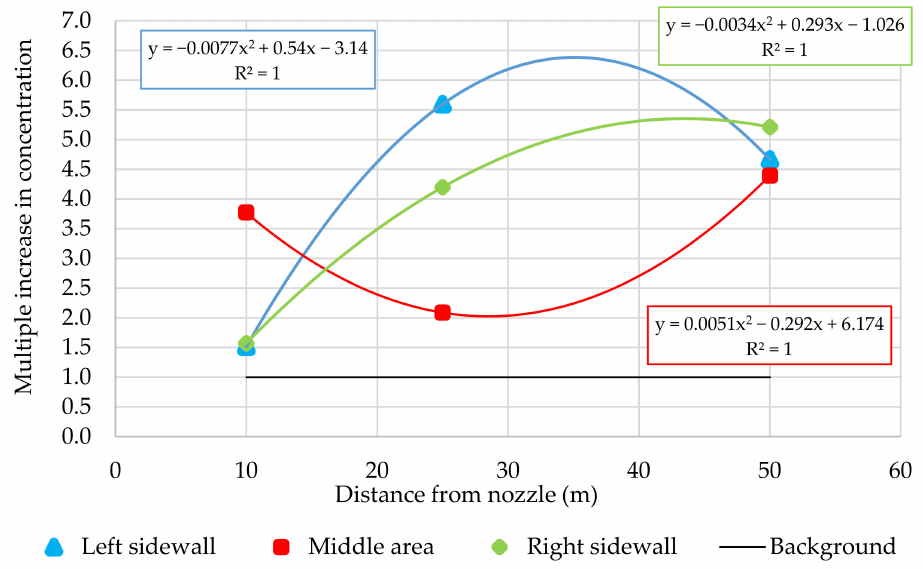
Figure 17. Distribution of the concentration of ultrafine aerosols as a function of the distance from the nozzle at a height of 1.55 m above the excavation